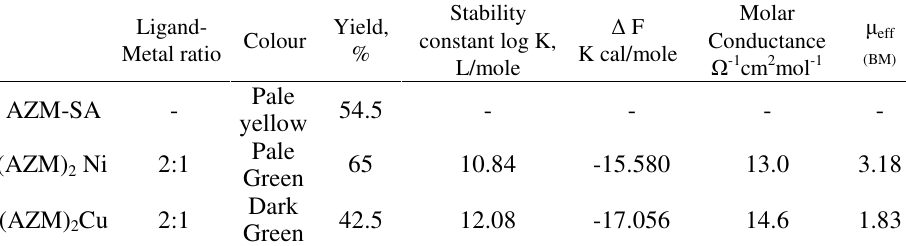
Table 1. Synthesis and physicochemical characteristics of complexes